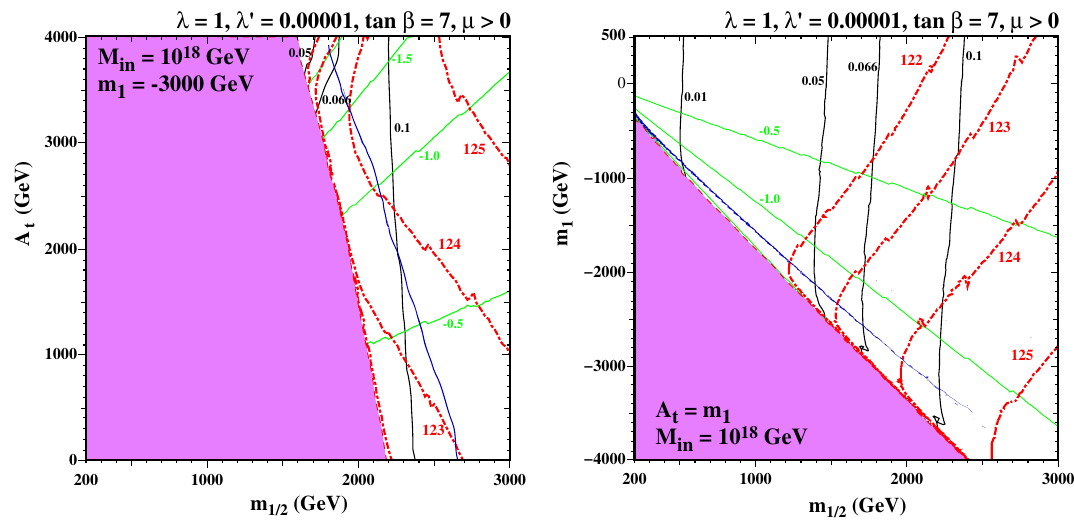
Fig. 6 Left panel the ( A t , m 1 / 2 ) plane for tan β = 7 ,λ = 1 and and β (cid:3) = 0. For the left panel α t varies and m 1 is fixed while for the = 10 18 GeV, m = 0 and m = − 3000 GeV λ (cid:2) = 10 − 5 with M right panel A t = m 1 ( α t = − 1) and all other A i = B i = 0. The shad- in 0 1 ings and contour colors are the same as in Fig. 1. The width of the relic when only H is twisted. Right panel the corresponding ( m 1 / 2 , m 1 ) density region ( shaded blue ) has been enhanced for better plane. Here, the modular weights are α b = 1, α λ = 1, α λ (cid:2) = 0, β H = 1